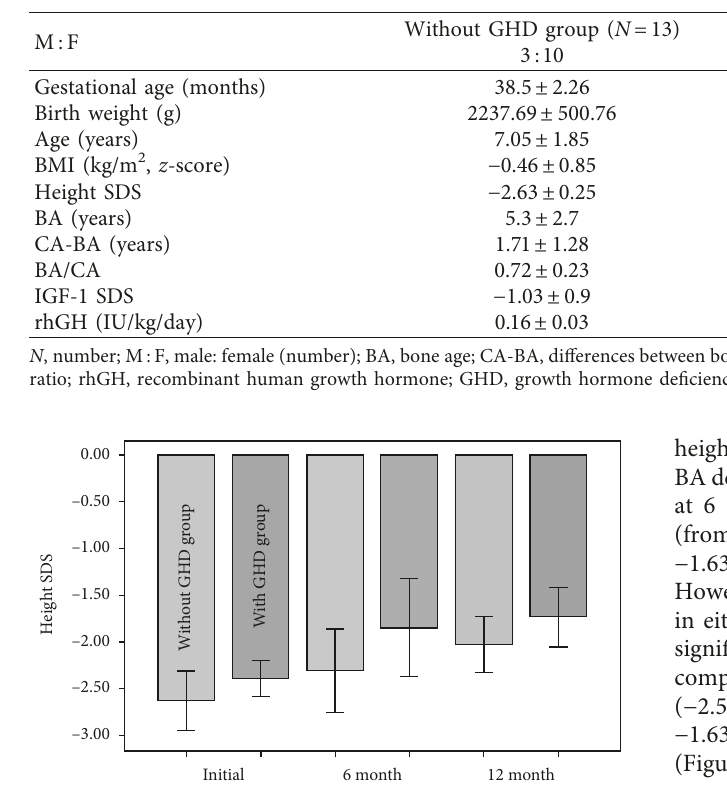
Table 2: Initial clinical and laboratory characteristics when patients were classified according to the presence of growth hormone deficiency (GHD).